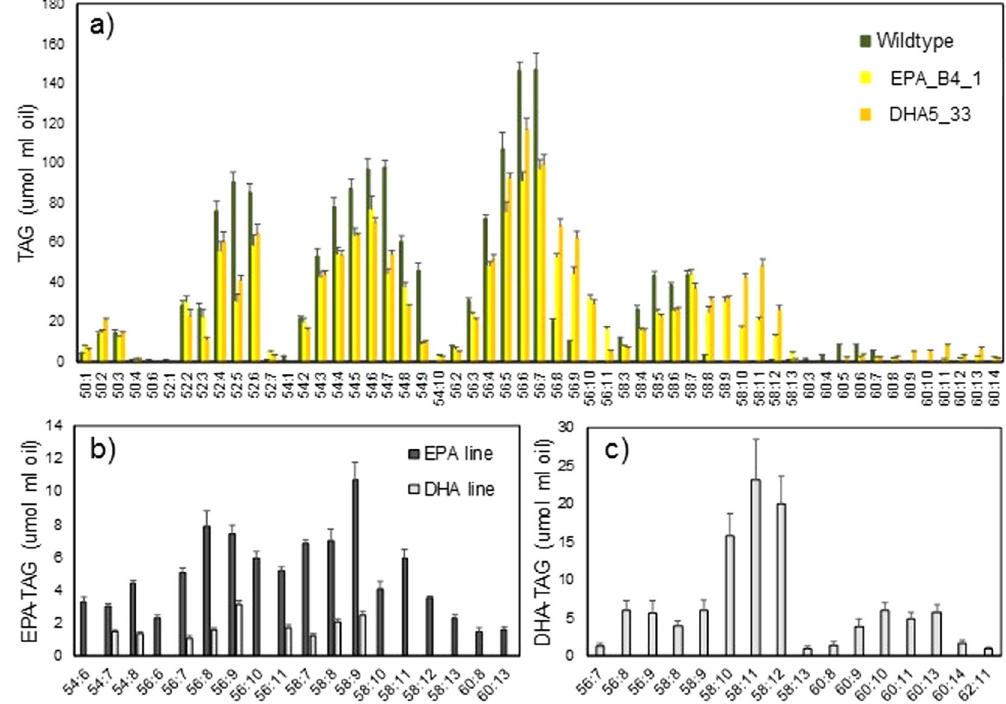
Figure 5. Analysis of triacylglycerols from mature C. sativa seeds. TAG molecular species were characterised from wild-type, EPA_B4_1 and DHA5_33 using a ESI-MS/MS neutral loss survey scan with each TAG species represented by the total number of fatty acid carbon atoms:desaturations. A Students T-test was used to independently compare C. sativa wildtype with EPA-B4_1 and DHA5_33. Those TAG molecular species with significantly (p 0.05) different accumulations are shown ( a ). Further analysis of the mass spectrometry data acquired for the engineered lines identified those significant TAG species containing either EPA ( b ) or DHA ( c